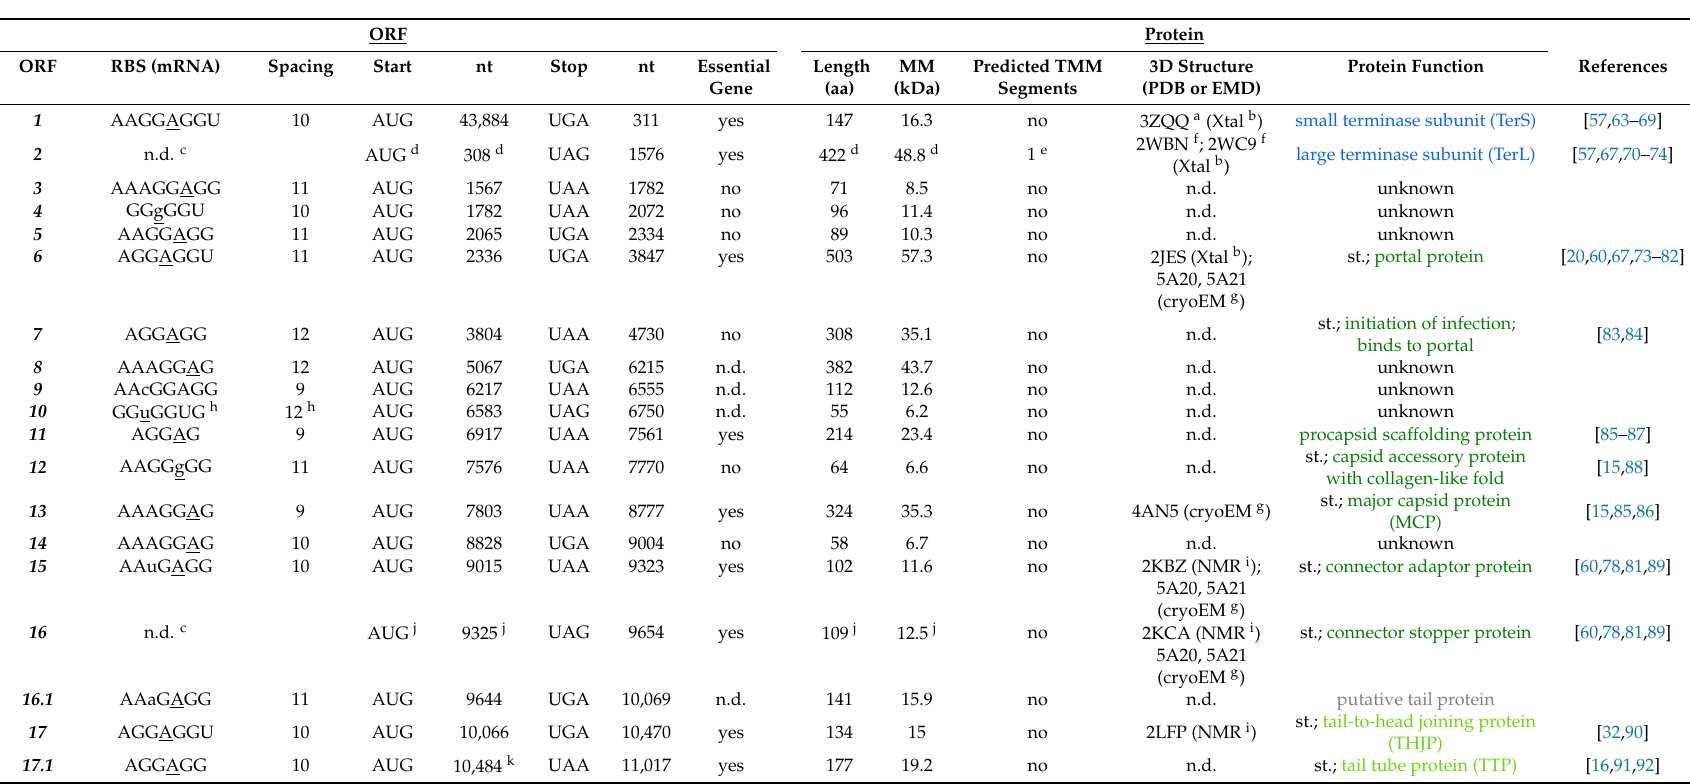
Table 3. SPP1 ORFs. The 80 ORFs of the SPP1 transcribed heavy chain were assigned as described in Material and Methods (see Section 2) and numbered following the original nomenclature of Alonso et al. [26]. The RBS are sequences complementary to the B. subtilis 16 S rRNA 3 (cid:48) sequence (mismatches are shown in small case; the position after which spacing is calculated between the RBS and the nucleotide preceding the initiation codon is underlined; n.d.—not determined). The ORFs coding regions coordinates are listed. Genes are defined essential when their inactivation in conditional lethal mutants prevents phage multiplication.The length, molecular mass (MM) and presence of putative transmembrane segments in proteins translated from the ORFs coding frame are listed on the right side of the Table. The coordinates of X-ray crystallography, NMR or cryo-electron microscopy structures available for individual proteins or their complexes are also provided. The function of individual proteins is based on experimental data while putative function is deduced from bioinformatics analysis. Structural components of the SPP1 viral particle (st.) are assigned based on biochemical, structural and/or robust bioinformatics data. Proteins are grouped according to function following the color code used in Figure